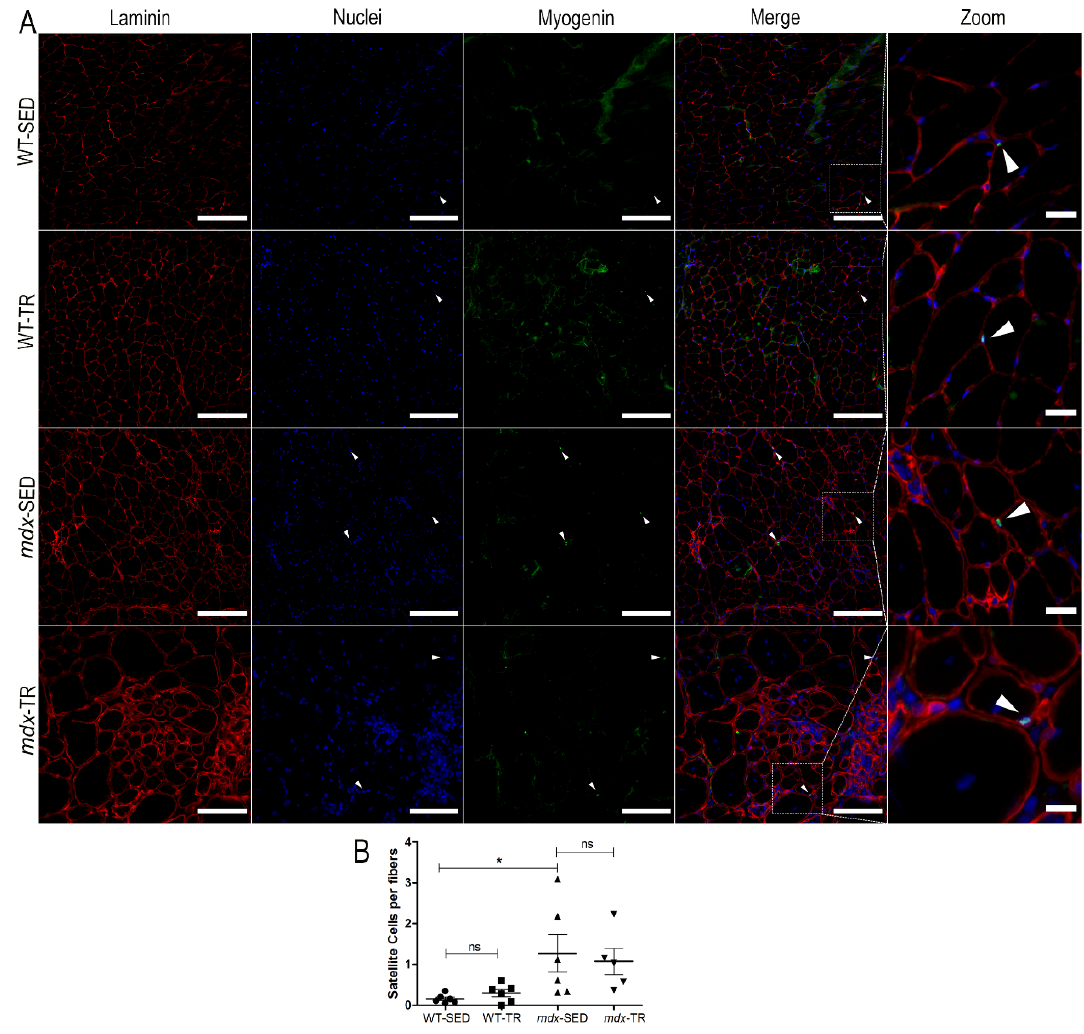
Figure 4. Myogenin (satellite cells) content is increased in sedentary mdx mice. ( A ) Representative images of immunostaining of SC in differentiation/fusion through the F5D antibody (myogenin). Laminin (red, Cy5), nuclei (blue, DAPI), and myogenin (green, FITC) are shown. White arrows: Indication of SCs (F5D + underlying nuclei). Images were obtained with the ImageXpress XLS System microscope at 20× magnification. Scale bar = 100 µm (laminin, nuclei, myogenin, and merged panels). All zoomed areas provided better visualization of the SCs (scale bar = 30 µm). SCs were identified by their localization below the laminin superimposed with the nuclei. ( B ) As expected, the WT-SED group had fewer SCs in differentiation/fusion when compared to the mdx -SED group. * p < 0.05, ns: not significant. Round symbol: WT-SED; Square symbol: WT-TR; Triangle symbol: mdx- SED; Inverted triangle symbol: mdx -TR. Abbreviations: WT-SED: sedentary wildtype; WT- TR: trained wildtype; mdx -SED: sedentary mdx ; mdx -TR: trained mdx . 2.3. PGC-1 α Is Increased in Dystrophic Muscles Fluorescence measurements for the PGC-1 α protein showed that DMD increased the oxidative characteristics of the psoas muscle, as we observed a higher amount of the pro- tein in the mdx -SED group when compared to the WT-SED group (WT-SED × mdx -SED, p < 0.05) (Figure 5A,B). As expected, the low-intensity aerobic training, applied for a long period, increased the amount of PGC-1 α in both trained groups (WT-TR and mdx -TR) when compared to their respective sedentary groups (Figure 5A,B).